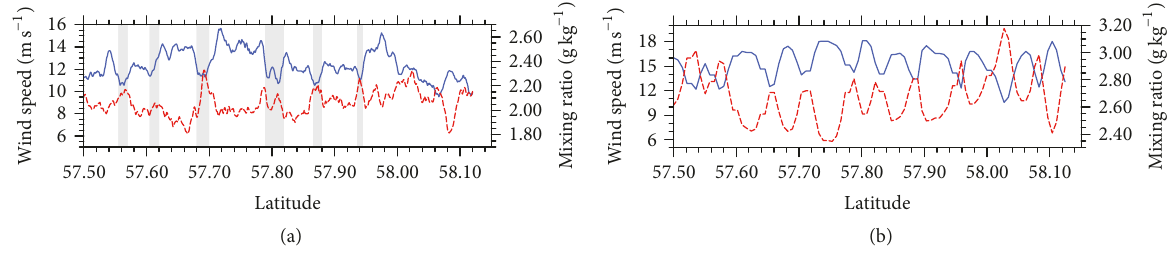
Figure 3: Horizontal wind speed (blue) and mixing ratio (red) from (a) a flight leg along the mainland coast on 3 May 1997 1512–1526 UTC and (b) the corresponding WRF data from 1500UTC. The filled areas show regions were updraughts can be